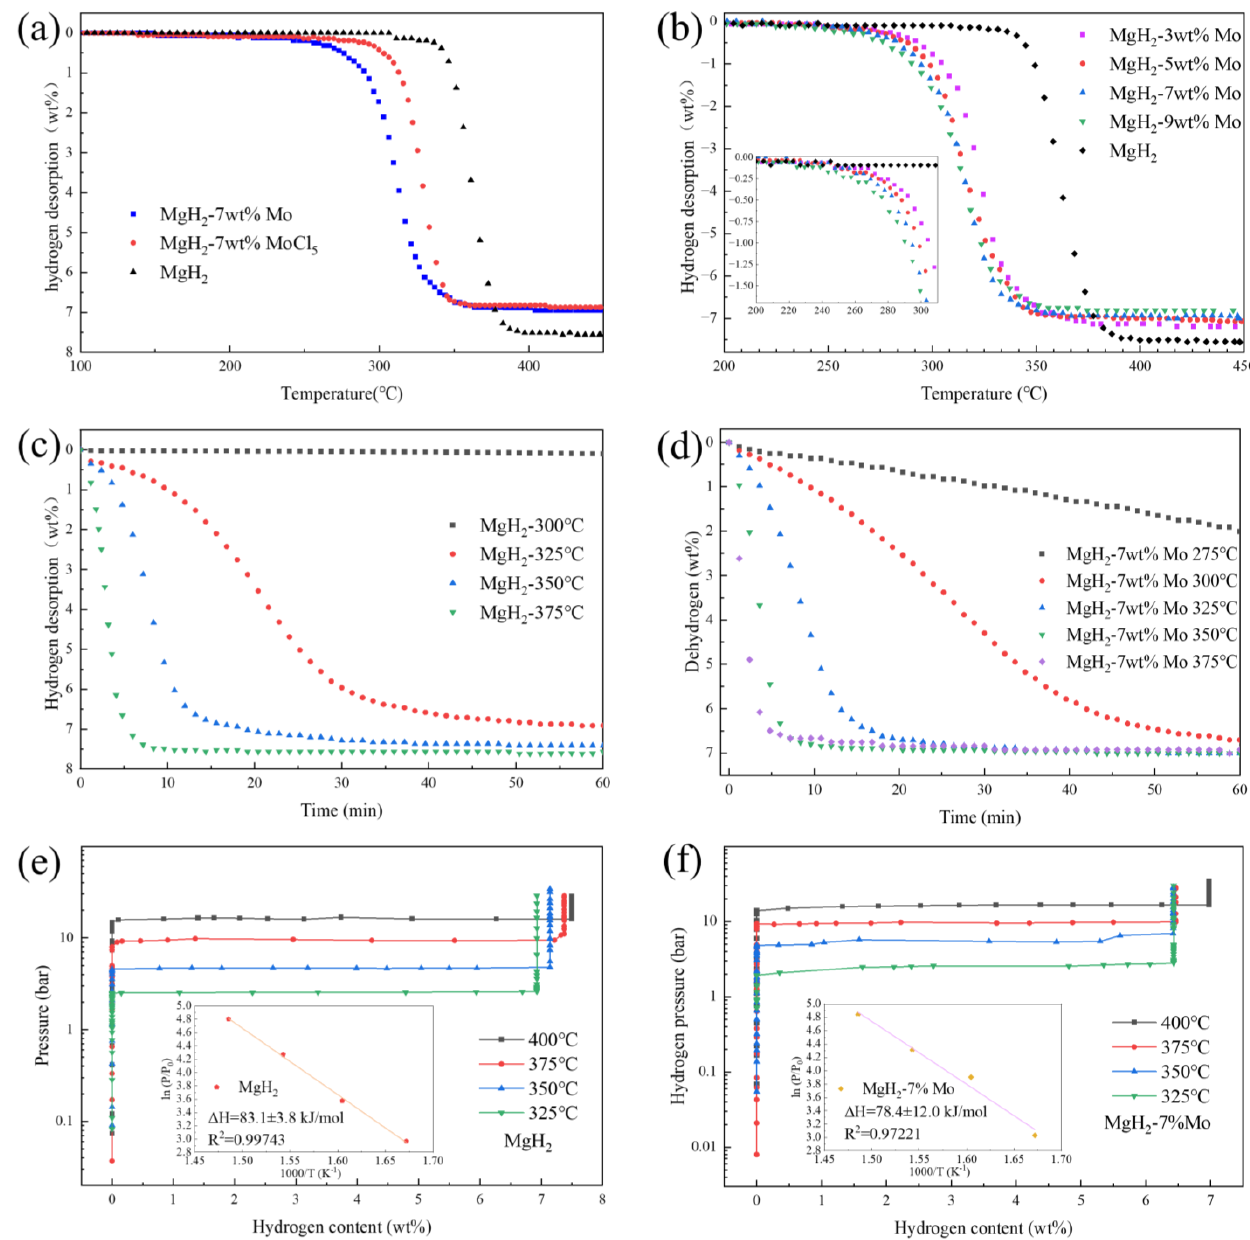
Figure 2. ( a ) Non-isothermal dehydrogenation curves of MgH 2 , MgH 2 -7wt%MoCl 5 , and MgH 2 - 7wt%Mo; ( b ) non-isothermal dehydrogenation curves for MgH 2 , MgH 2 -3wt%Mo, MgH 2 -5wt%Mo, MgH 2 -7wt%Mo, and MgH 2 -9wt%Mo; ( c ) isothermal dehydrogenation curves of MgH 2 at 300, 325, 350, and 375 °C; ( d ) isothermal dehydrogenation curves of MgH 2 -7wt%Mo at 275, 300, 325, and 350 °C; ( e ) pressure-composites-temperature (PCT) curves of MgH 2 at different temperatures, and cor- responding van’t Hoff plot ; ( f ) pressure-composites-temperature (PCT) curves of MgH 2 -7wt%Mo at different temperatures, and corresponding van’t Hoff plot.